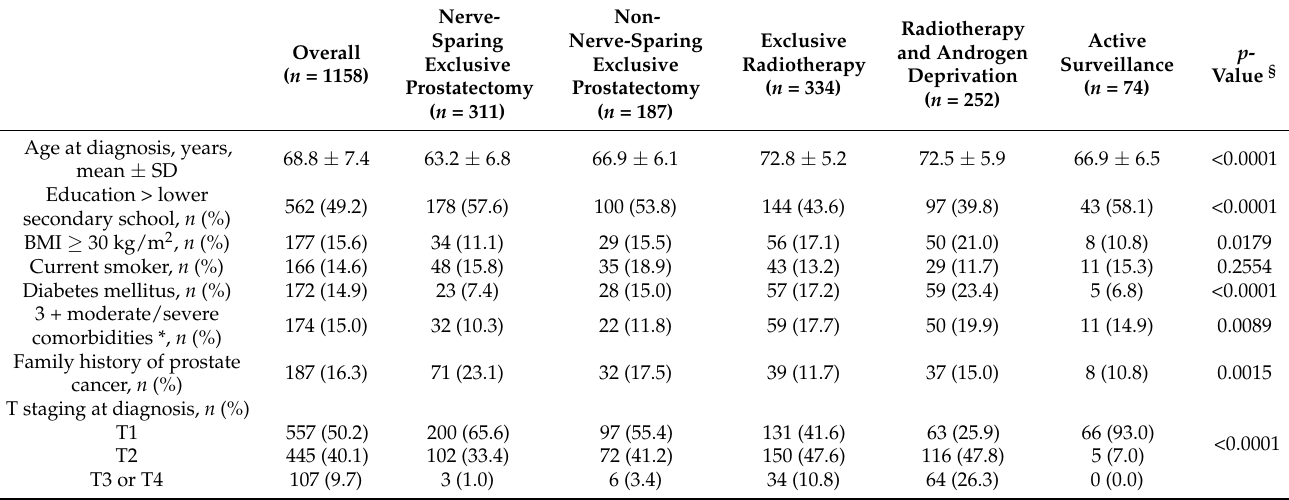
Table 1. Characteristics at the time of diagnosis of the Pros-IT population